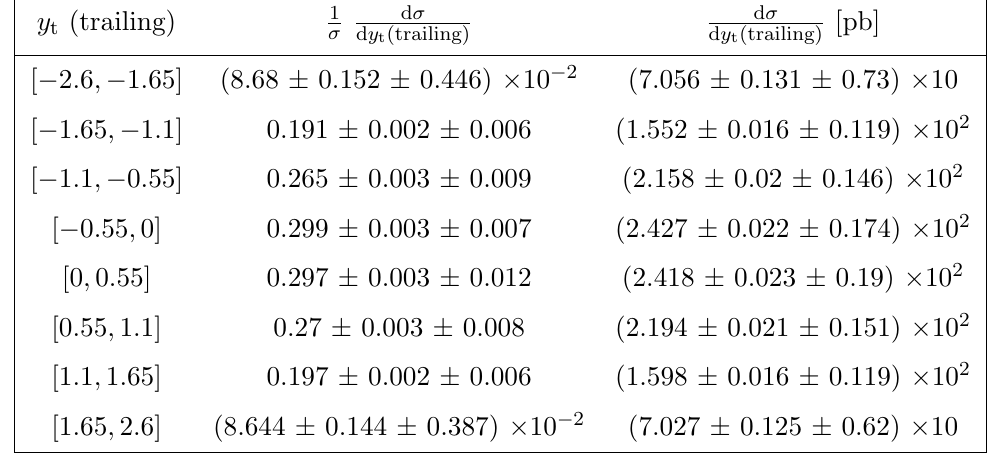
Table 9 . The measured di(cid:11)erential cross section and bin boundaries for each bin of the normalized and absolute measurements of the tt di(cid:11)erential cross section at parton level in the full phase space as a function of y t (trailing) are tabulated.